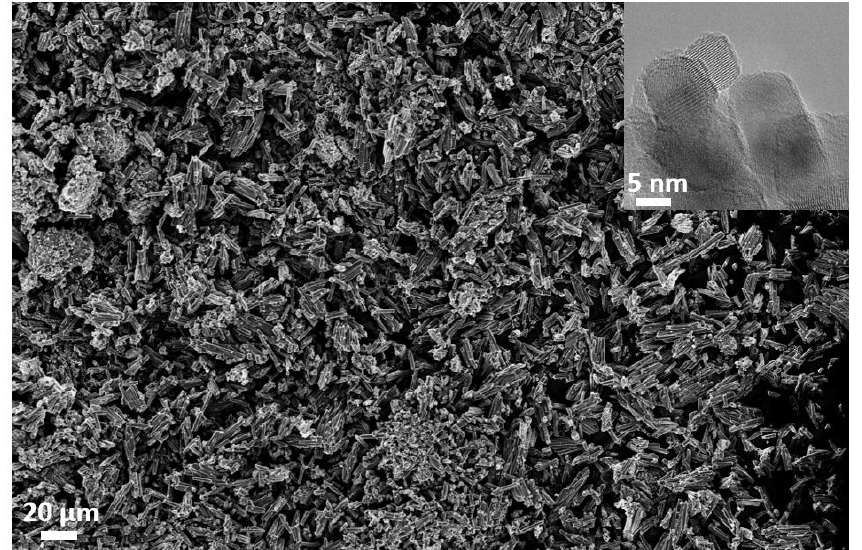
Figure 2. SEM micrograph of Ti-600 showing the rod-like structure of the TiO 2 aggregates. Inset: high-resolution TEM micrograph of Ti-600, displaying highly crystalline nanoparticles.